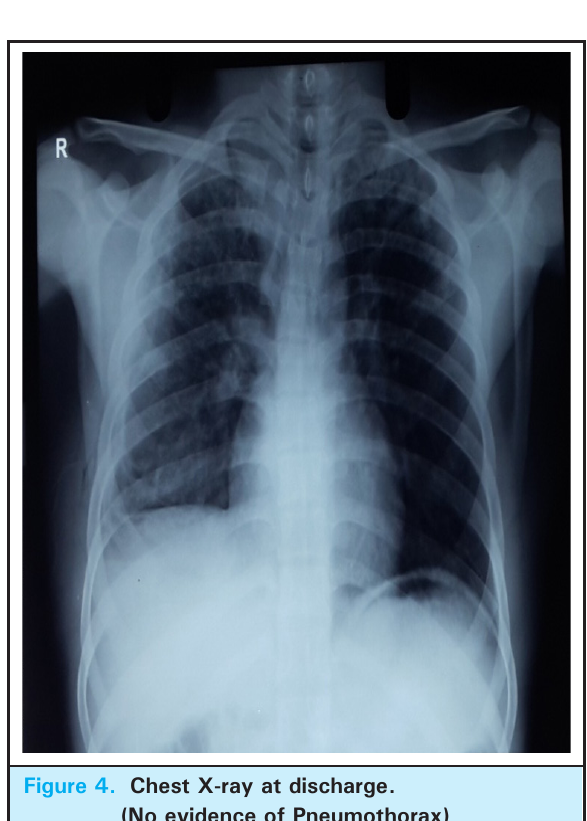
Figure 3. CT chest showing right Pleural effusion and Pneumothorax.